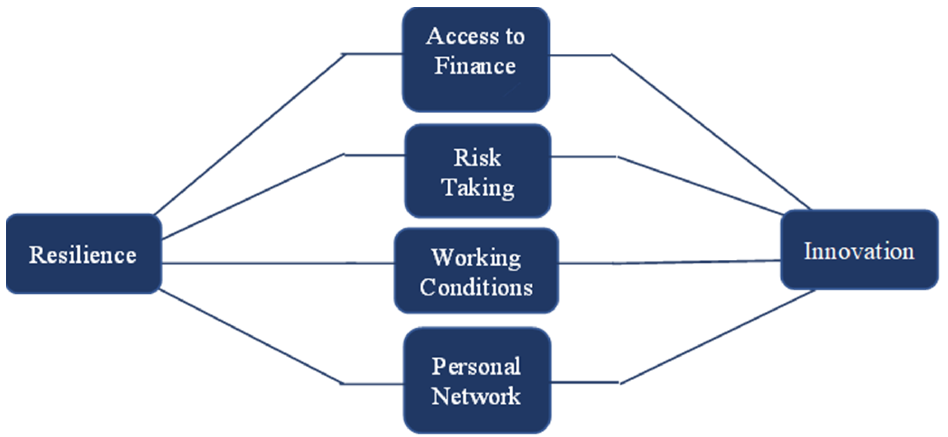
Figure 1. Conceptual